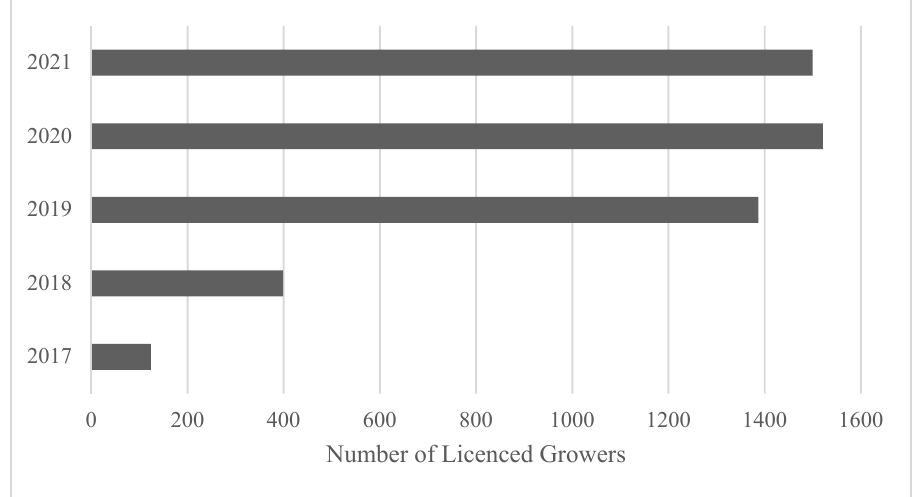
Figure 2. Licensed Hemp Growers in NC, 2017–2021, National Hemp Report, 2022. Note: The NC